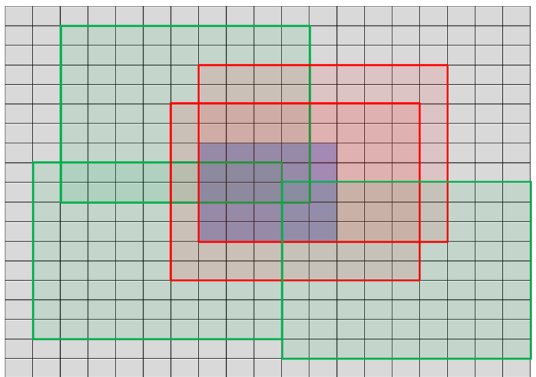
Figure 16. Illustration of the sample blocks included (green) and excluded (red) from the calculations of blocks predictability.